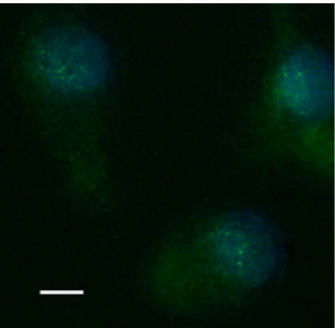
Figure 8. Fluorescence image of translocation of nuclear factor NF- κ B in PBM cells stimulated by paramylon nanofibers. Bar 10 µ m.